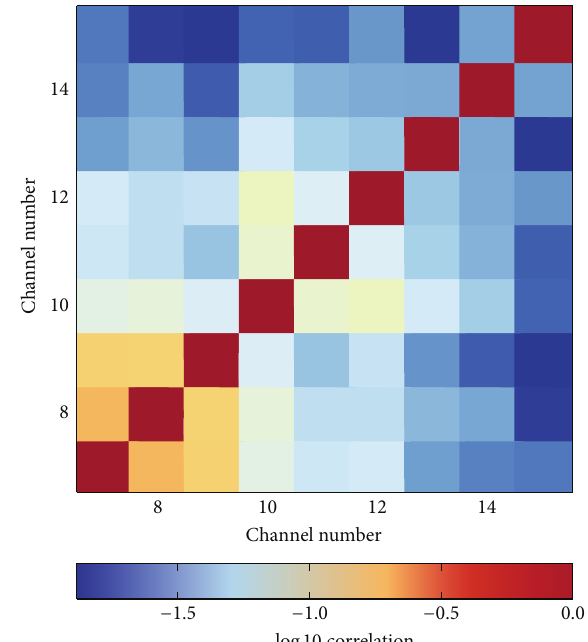
Figure 5: ATMS interchannel correlations. Note that all correlation coefficients are positive, so they can be displayed on a logarithmic scale. Earth spots 90 – 93 , channel 7 1.0